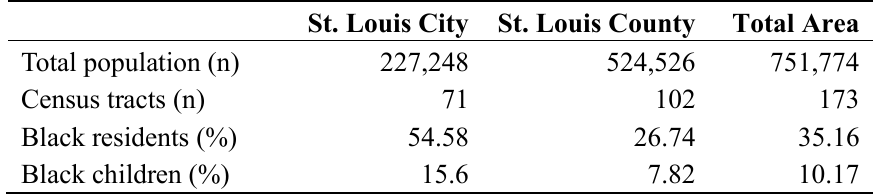
Table 1. General population characteristics of the sampled